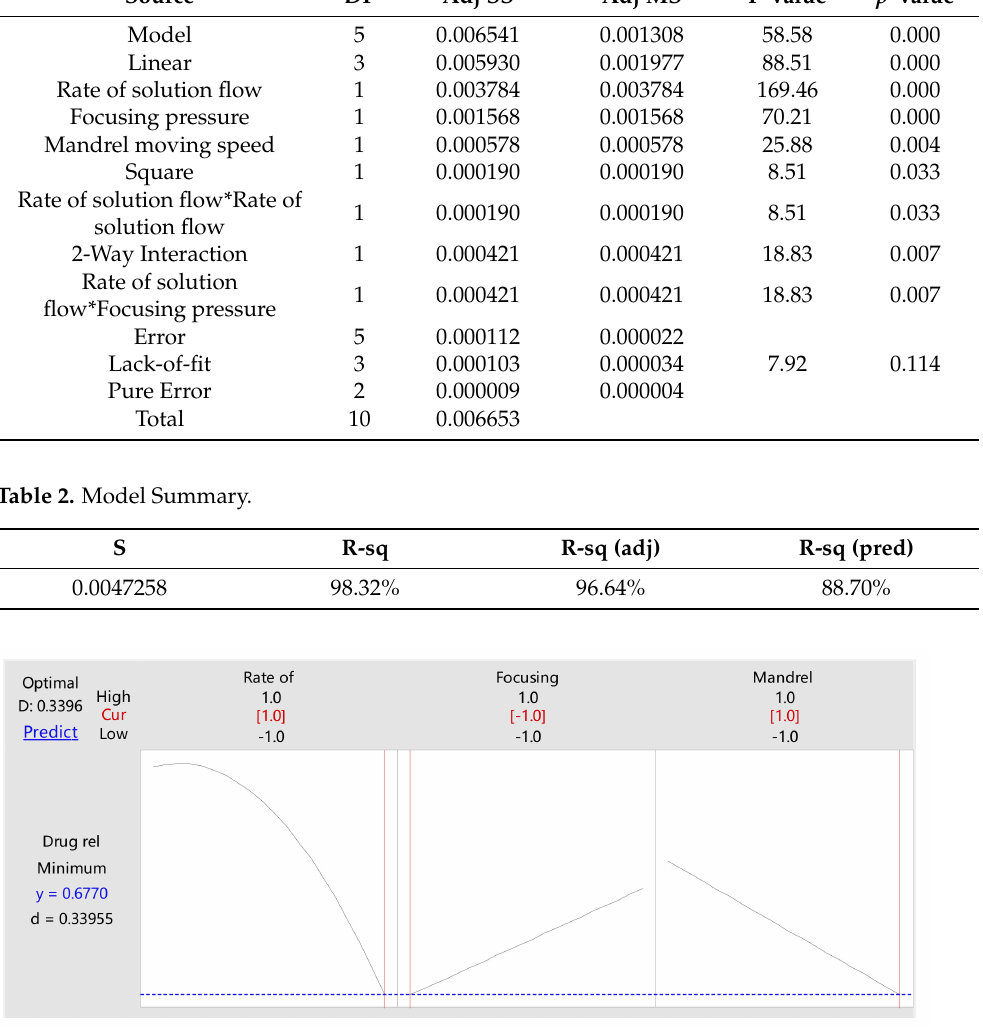
Figure 6. The response optimizer of